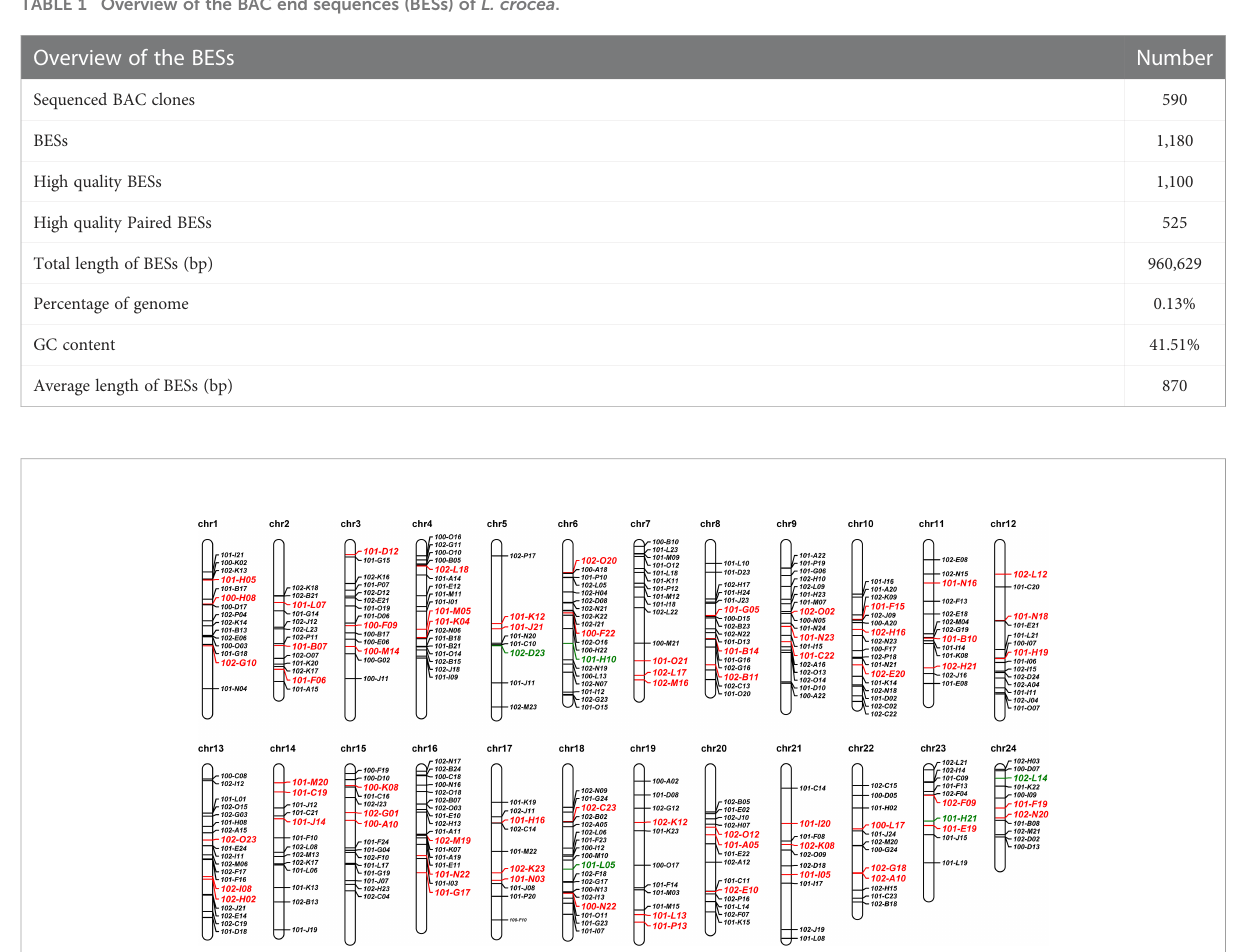
FIGURE 1 Genomic localization of BAC clones by aligning the end sequences of BACs to the reference genome of L. crocea . The BAC clones with color letters were selected for further FISH veri fi cation, red and greed indicating passed and unpassed,